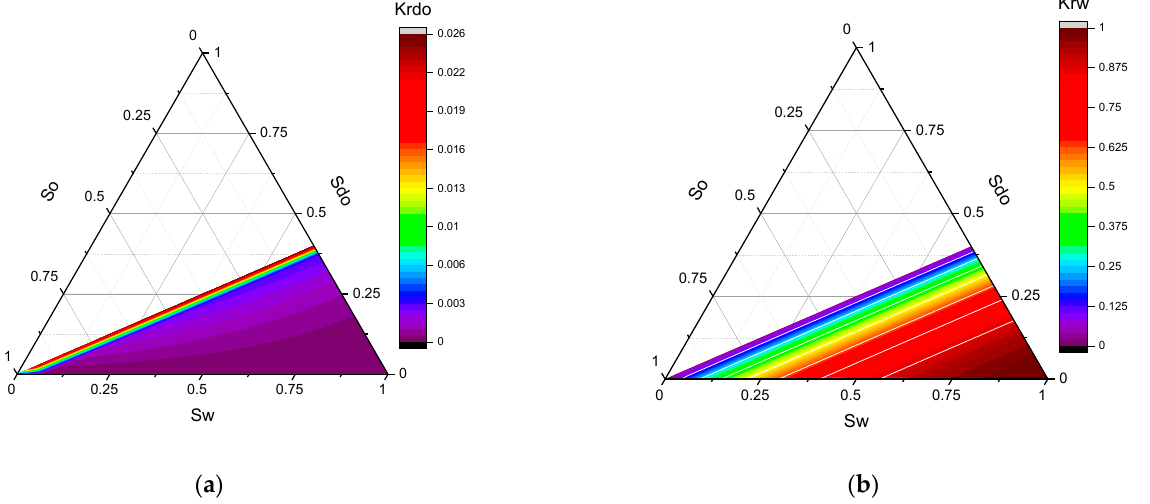
Figure 10. The relative permeability ternary diagrams of dispersed oil and continuous water phase when φ d = 0.4, λ = 0.9, and Ca = 10 − 4 . ( a ) Dispersed oil; ( b ) continuous